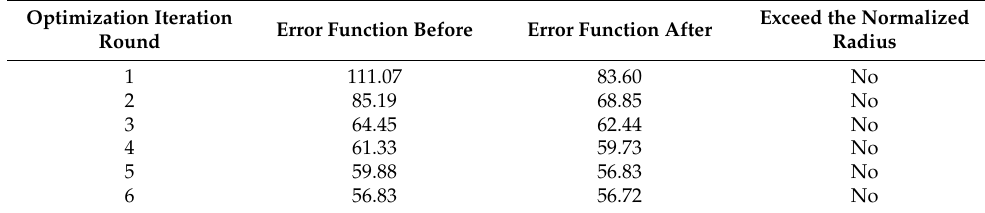
Table 7. Iterative optimization process for result 1 in Table 6.